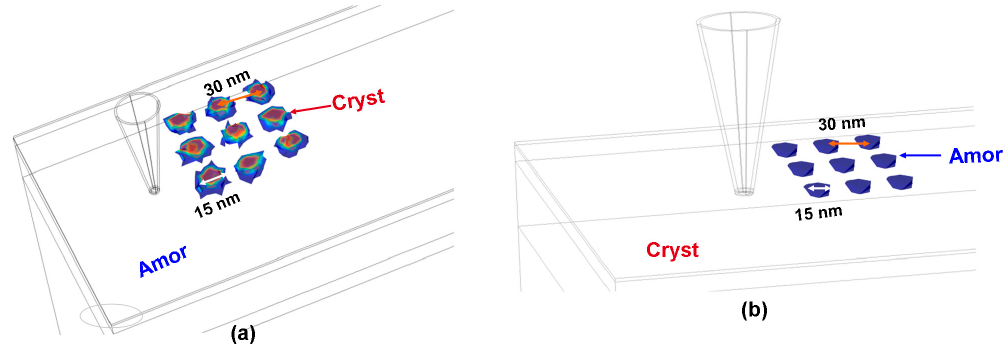
Figure 16. The generated 3 × 3 bit array using the developed 3D model with the optimized characteristic parameters in ( a ) crystalline and ( b ) amorphous phases.